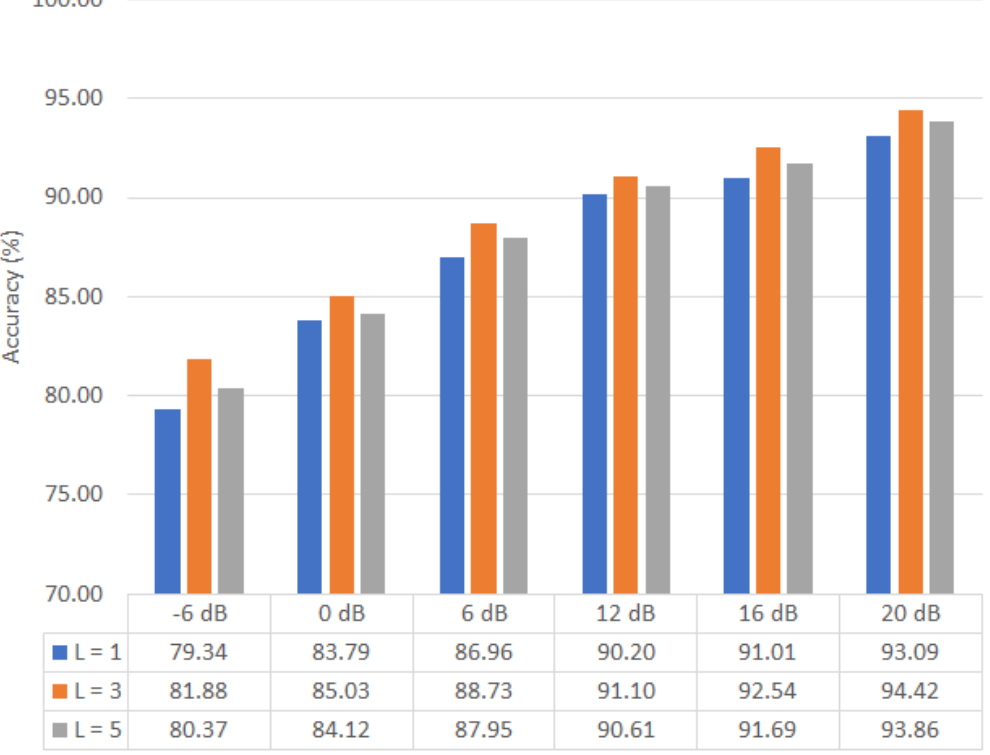
Figure 5. The classification accuracy (in percentages) of the acoustic wood logging using late fusion of the postprocessed outputs of the three top-performing classifiers (SVM, support vector machine (MLP), and C4.5 decision tree (J48)).